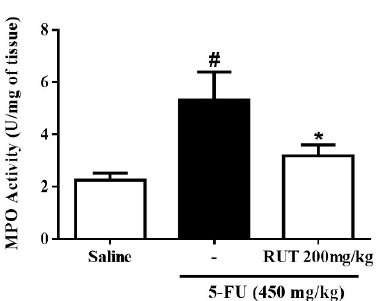
Figure 7. Myeloperoxidase (MPO) assay. Values are presented as mean ± SEM of MPO activity expressed in Unit (U) of MPO/mg in tissue. Statistical analysis was performed using the one-way analysis of variance followed by the Tukey’s test. # p < 0.05 vs. saline group and * p < 0.05 vs. group